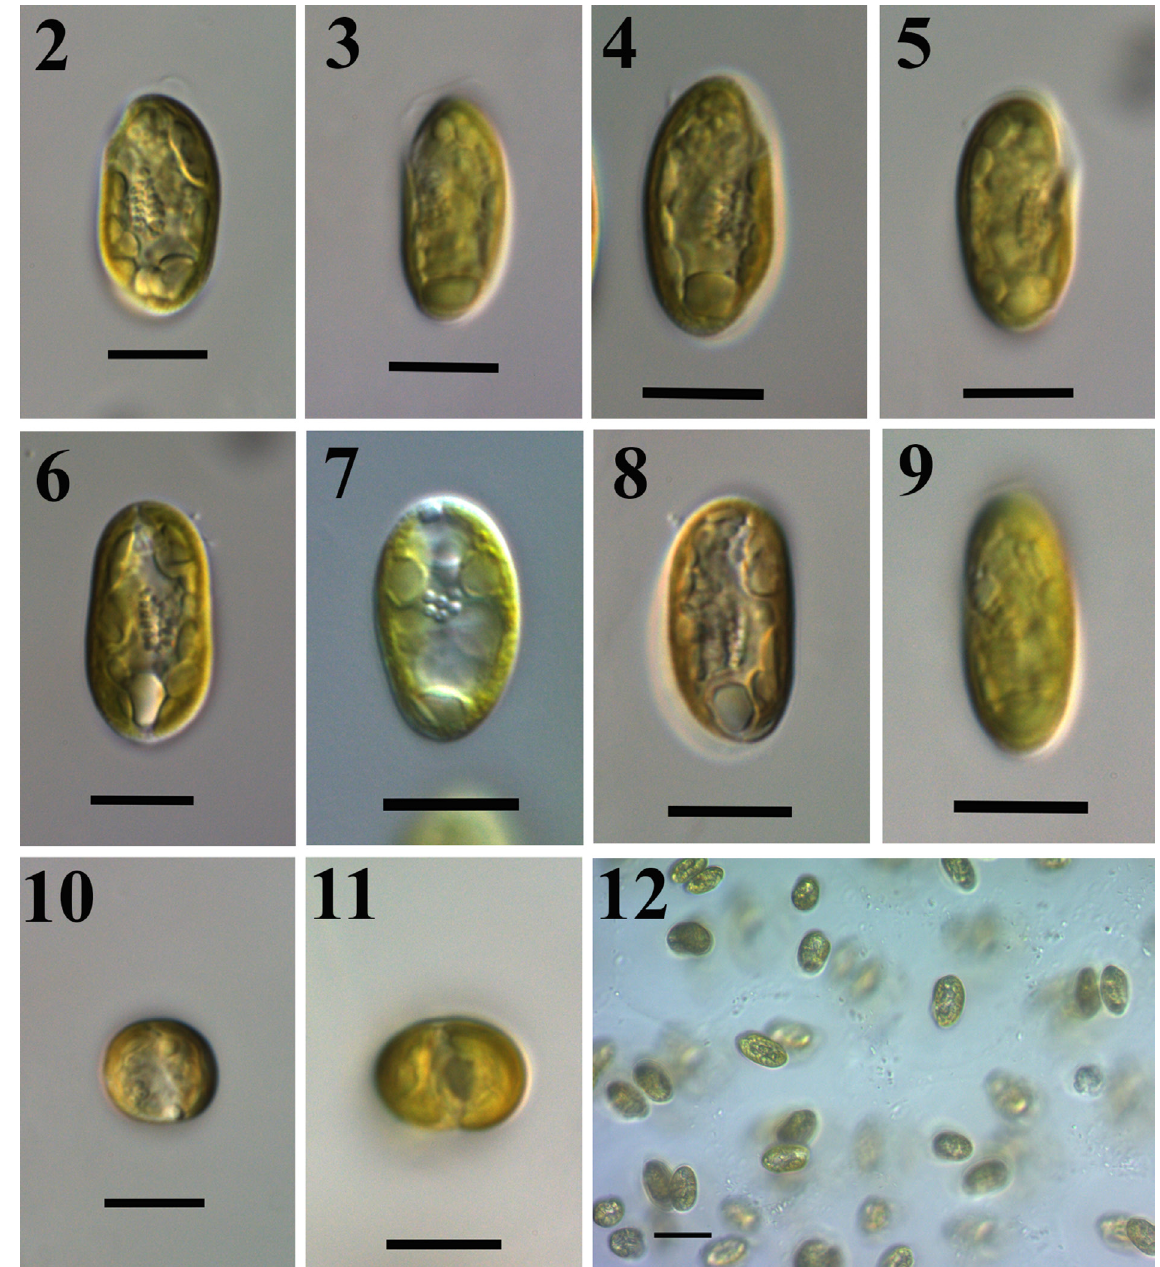
Figs 2–12. Light micrographs of Cryptomonas uralensis Martynenko, Gusev, Kulizin & Guseva sp. nov. (strain UR168). 2–3 . Lateral view (left side). 4–5 . Lateral view (right side). 6–8 . Ventral view. 9 . Dorsal view. 10–11 . Apical view. 12 . Cells of the strain UR168 in mucilage. Scale bars: 10